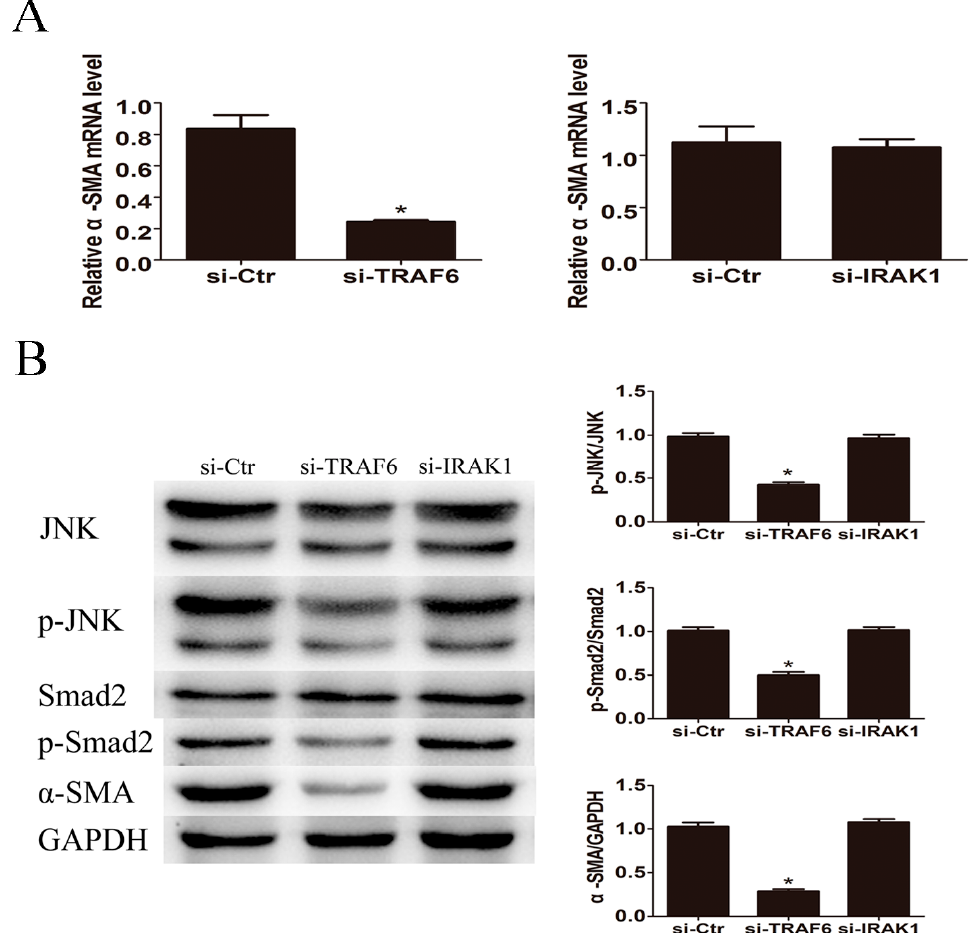
Figure 6. TRAF6 siRNA reduced LPS induced JNK activation and α -SMA expression. After incubation with TRAF6 siRNA or IRAK1 siRNA for 48 h, LX2 cells were treated with 500 ng/mL of LPS for 24 h. ( A ) TRAF6 siRNA but not IRAK1 siRNA decreased the mRNA expression level of α -SMA; ( B ) TRAF6 siRNA but not IRAK1 siRNA attenuated the activation of JNK and Smad2 and decreased the protein expression of α -SMA. * p < 0.05 vs. control group.